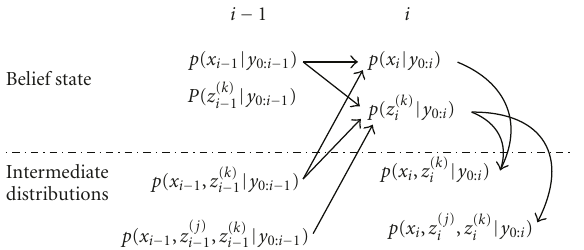
Figure 3: Belief state propagation in forward pass of Approximate inference I. We only need to maintain the belief state the interme- diate distributions can be calculated based on the independence assumptions when necessary, as indicated by the arrows within each time slice.